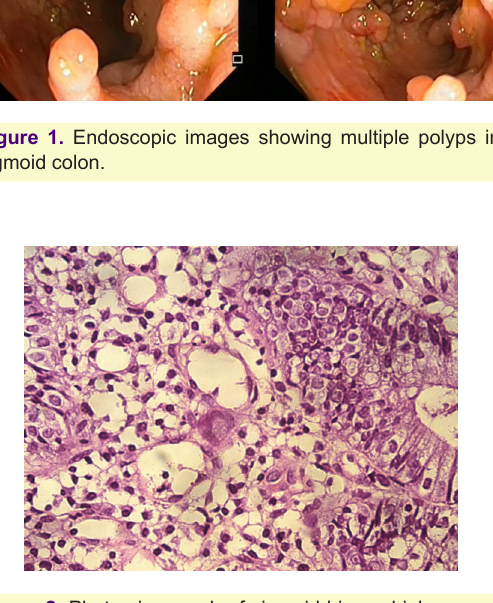
Figure 2. Photomicrograph of sigmoid biopsy high power view showing inclusion bodies suggestive of CMV colitis (×400,